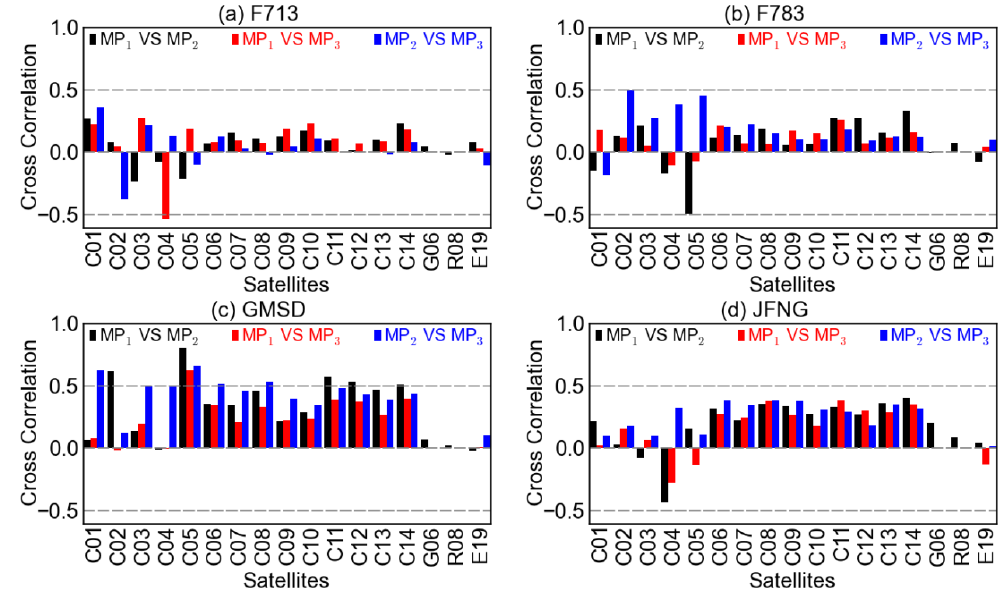
Figure 5. Cross-correlations between the code multipath combinations MP 1 and MP 2 (black), MP 1 and MP 3 (red), MP 2 and MP 3 (blue) at stations ( a ) F713, ( b ) F783, ( c ) GMSD, and ( d ) JFNG.